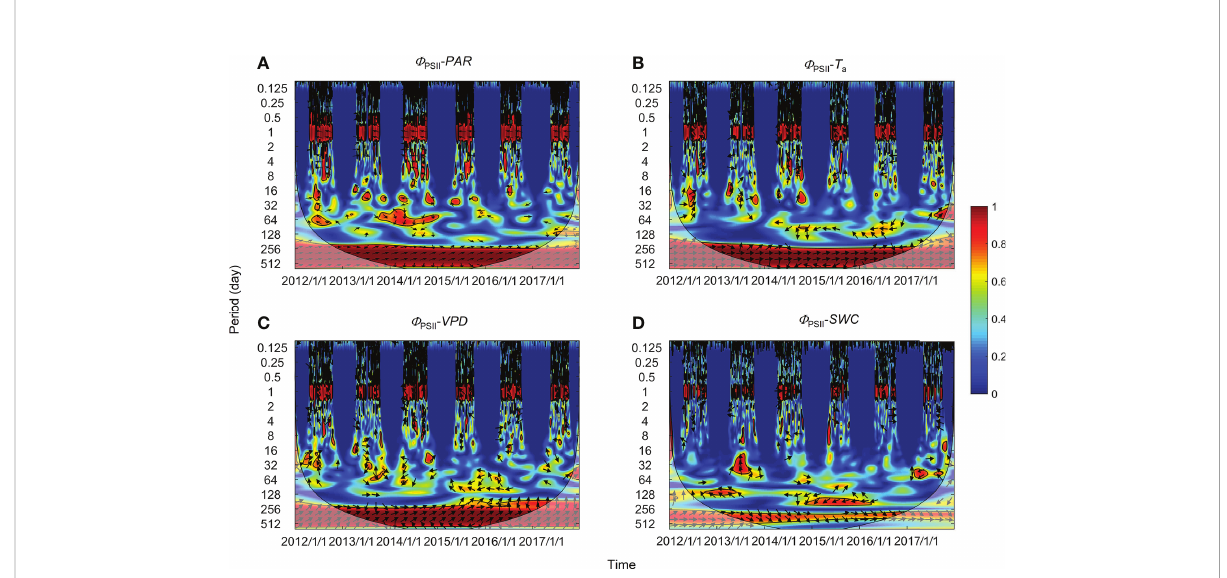
FIGURE 5 Wavelet coherence between photochemical ef fi ciency ( F PSII ) and (A) photosynthetically active radiation ( PAR ), (B) air temperature ( T a ), (C) vapor pressure de fi cit ( VPD ), and (D) soil water content at a 0.3-m depth ( SWC ). The phase difference is shown by arrows. Arrows pointing upward indicate environmental factors leading F PSII by 90°, whereas arrows pointing downward indicate environmental factors leading F PSII by 270°. Arrows pointing left (or right) indicate environmental factors and F PSII vary in-phase (or anti-phase). Black contour lines represent the 0.05 critical signi fi cance level. The thin arced lines denote the cone of in fl uence (COI) that delimits the region not affected by edge artefacts.